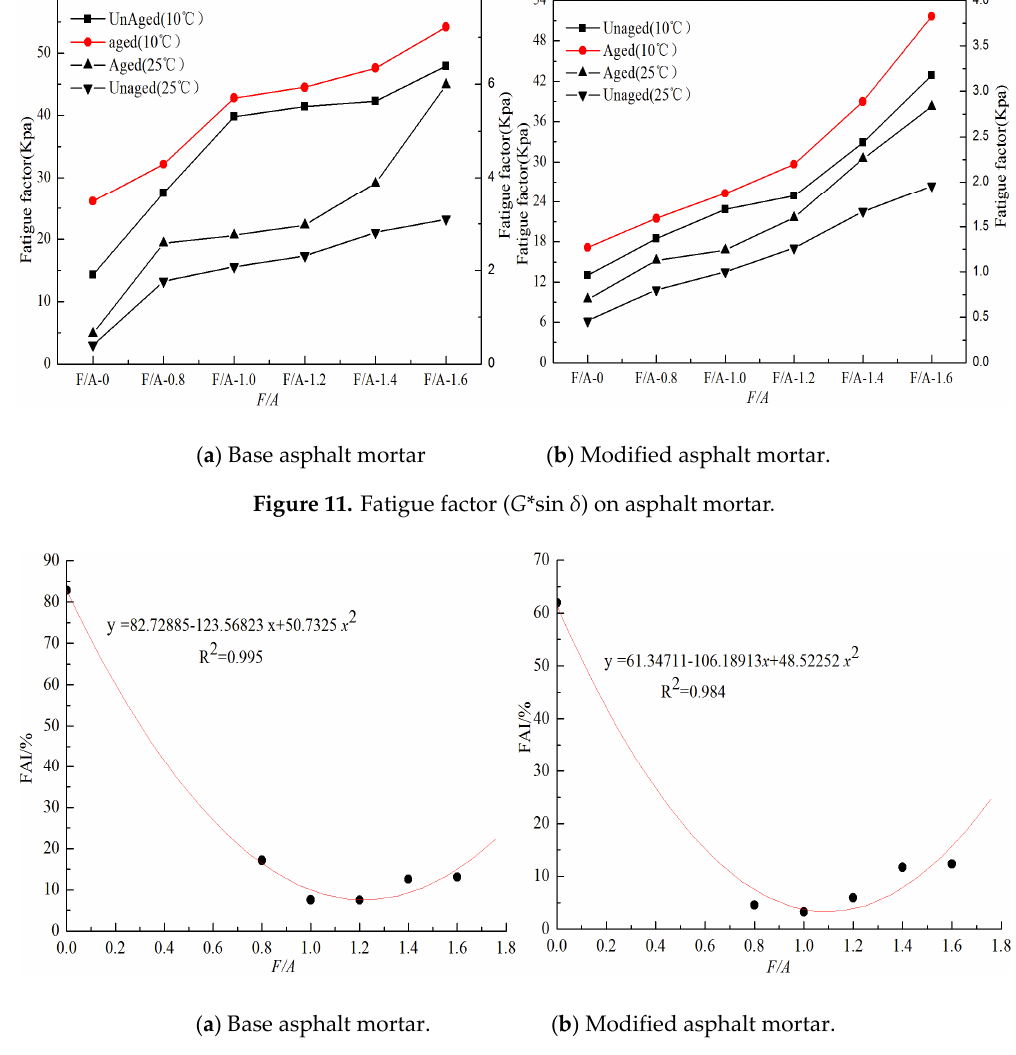
Figure 12. Fatigue factor aging index about these different types of asphalt mortar.